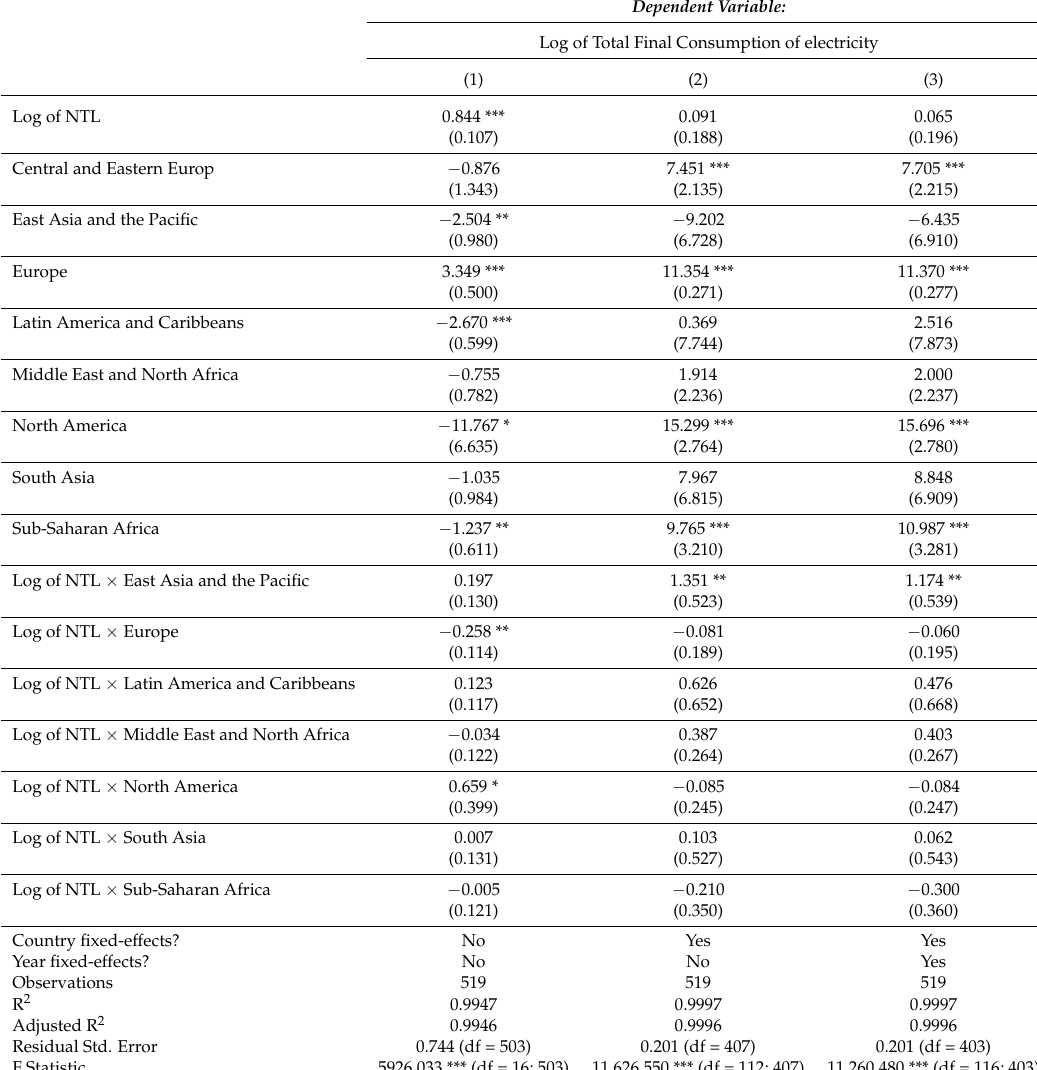
Table A5. Regression for COMMPUB—regional clustering.